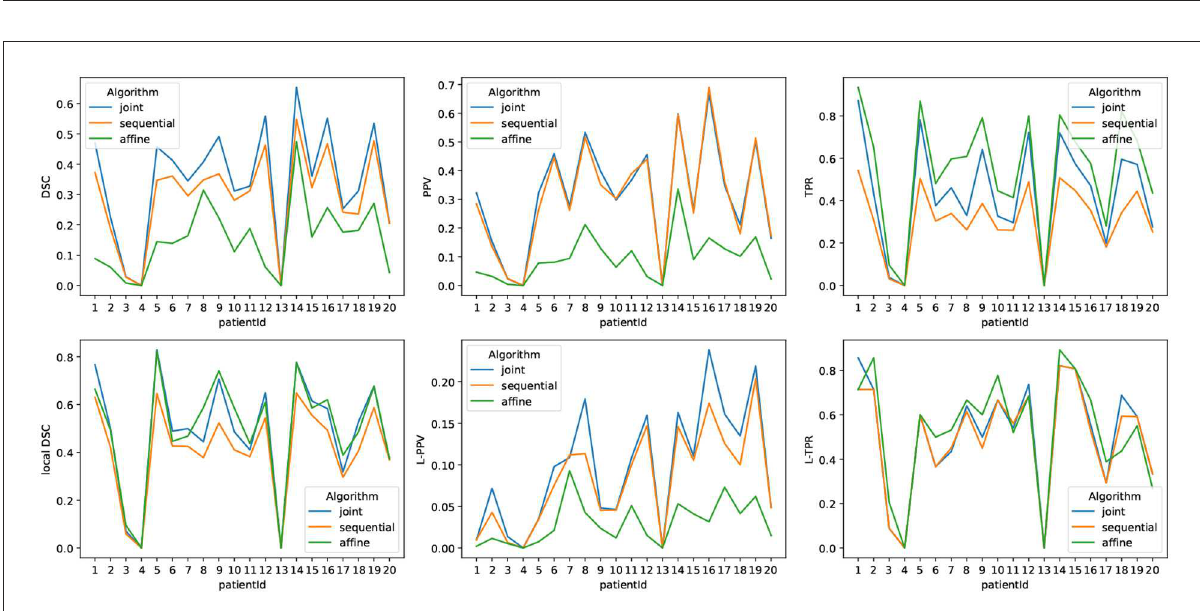
FIGURE6 Metrics reporting the performance of the three methods for each subject of LesjakDB.